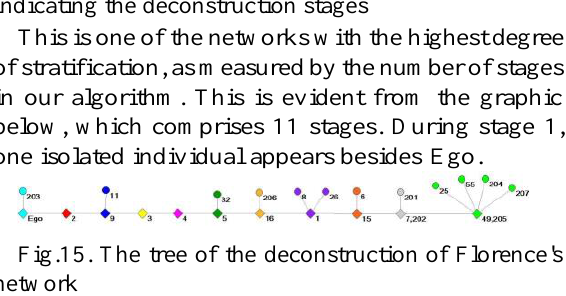
one isolated individual appears besides Ego.